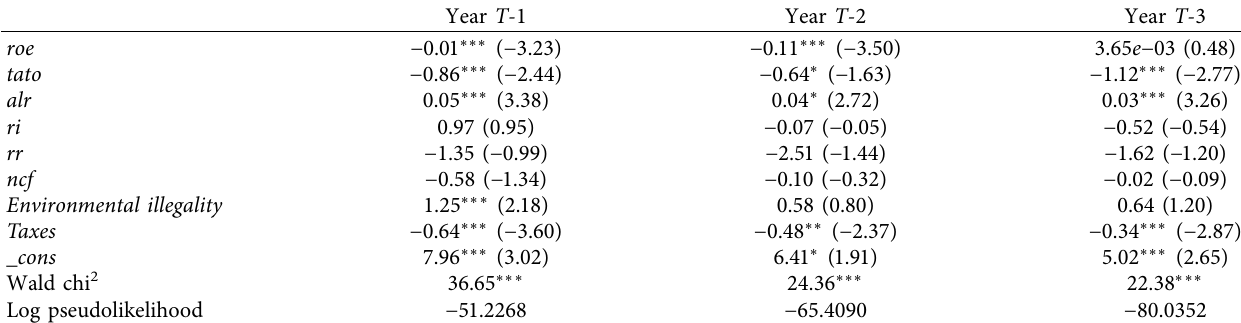
Table 6: Results of the logit